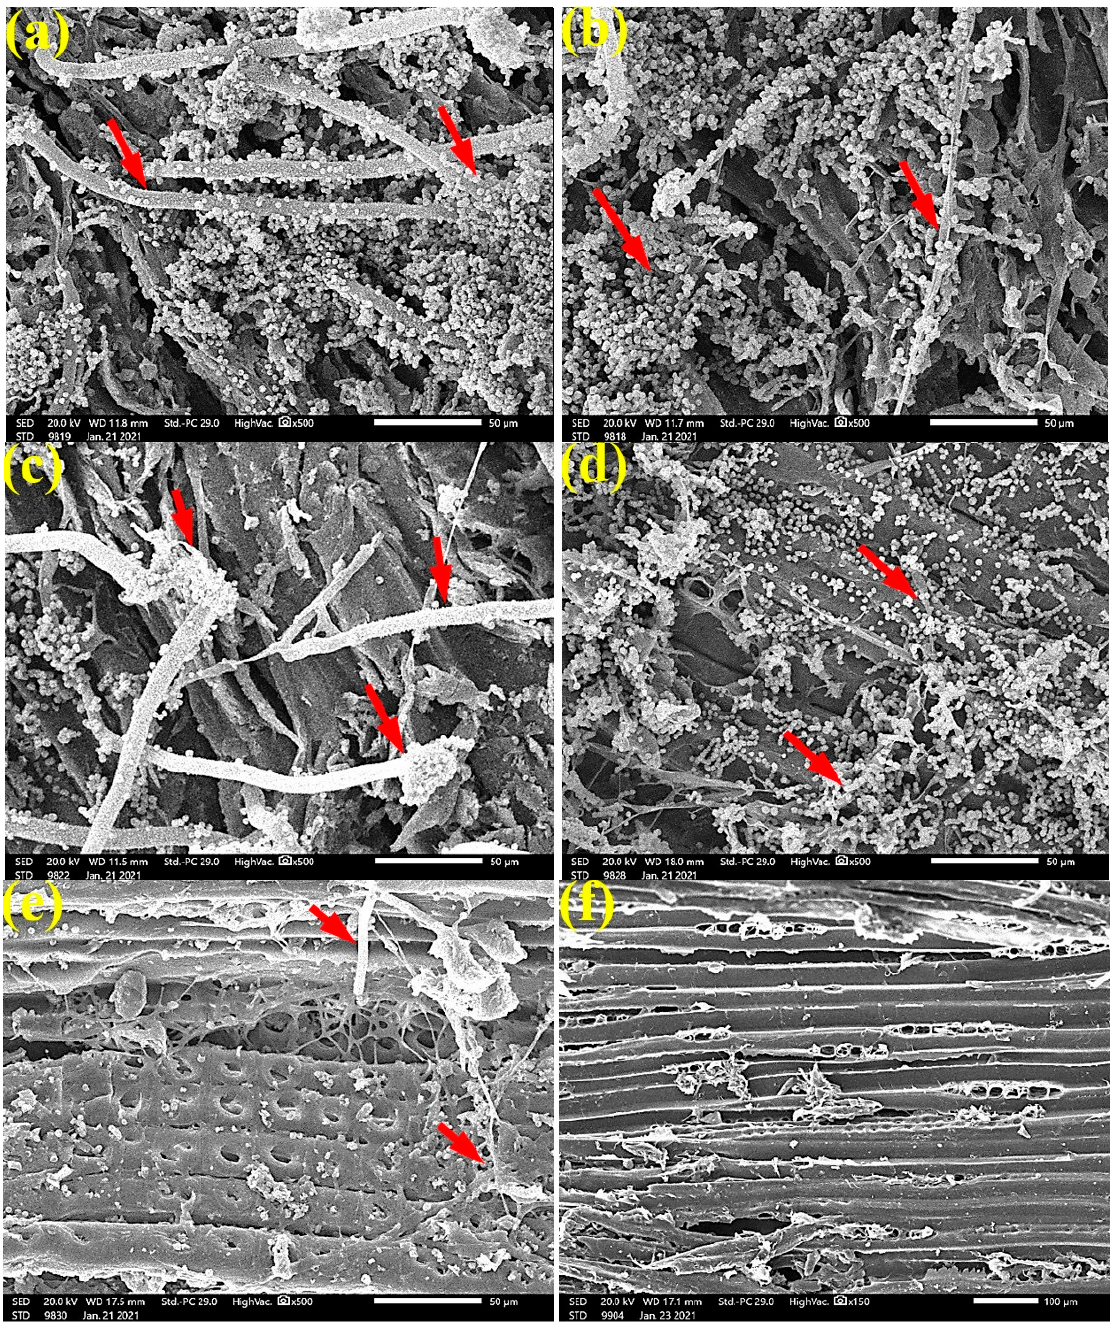
Figure 4. SEM images of P. roxburghii wood samples inoculated with A. flavus : ( a ) without treatment; ( b ) with 125 µL/mL C. reticulata EO; ( c ) with 65 µL/mL M. longifolia EO; ( d ) with 125 µL/mL M. longifolia EO; ( e ) with 65 µL/mL M. longifolia EO; ( f ) with 125 µL/mL M. longifolia EO. Arrows refer to the dense growth of fungal mycelia in wood samples, according to treatment.